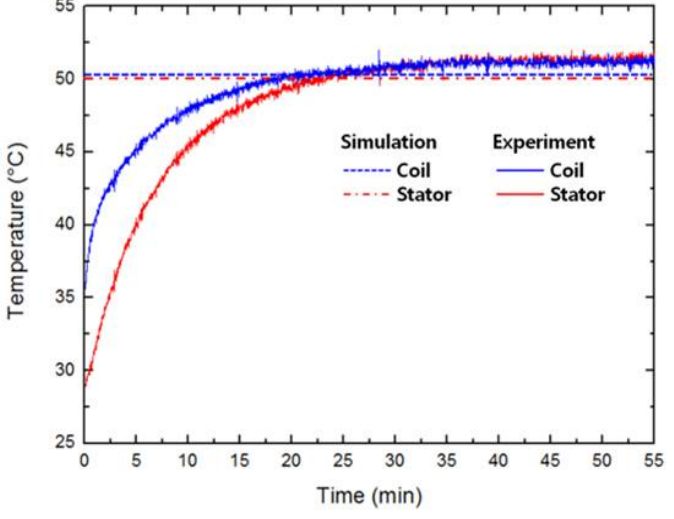
Figure 15. Temperature contours of ISG for reliability verification.